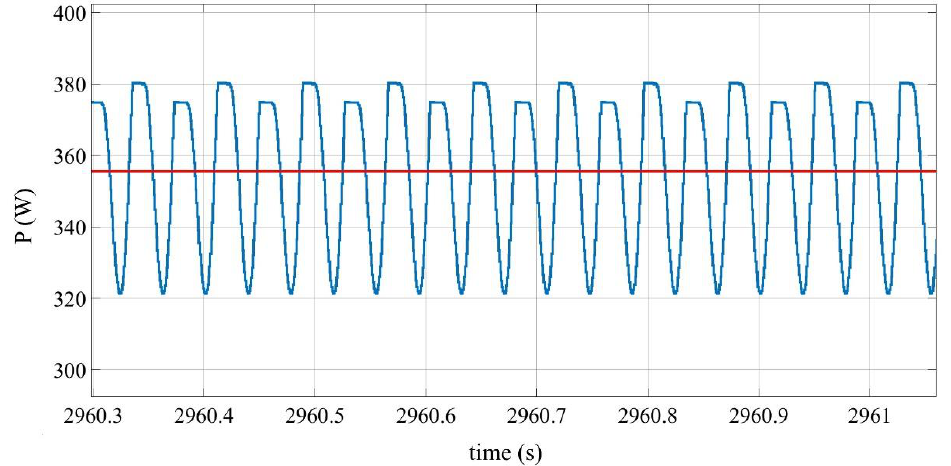
Figure 14. Total power dissipated by the transformer rectifier flux pump at steady state. Blue line is the instant dissipated power, red line is average dissipated power.